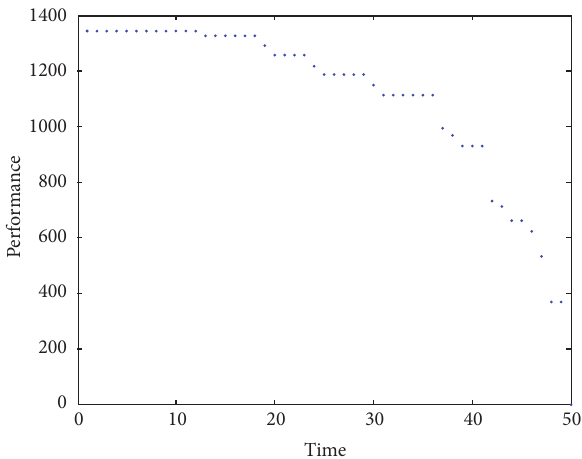
Figure 7: Resilience of cluster supply chain without recovery